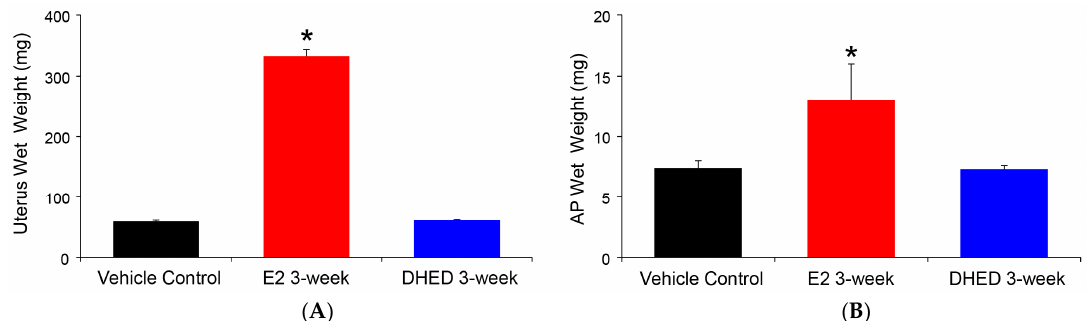
Figure 4. Assessment of peripheral exposure to E2 in ovariectomized (OVX) rats after three-week q.d. DHED or E2 eye drops (10 μ L, 0.1% w/v in 20% w/v HP β CD in saline solution). Tissues were